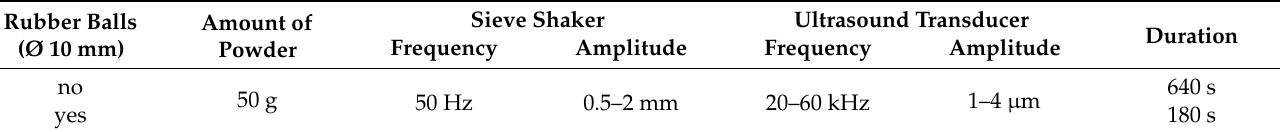
Table 2. Main settings of the shaker setup for processing of Si substrates with the powders in Table 1. Rubber